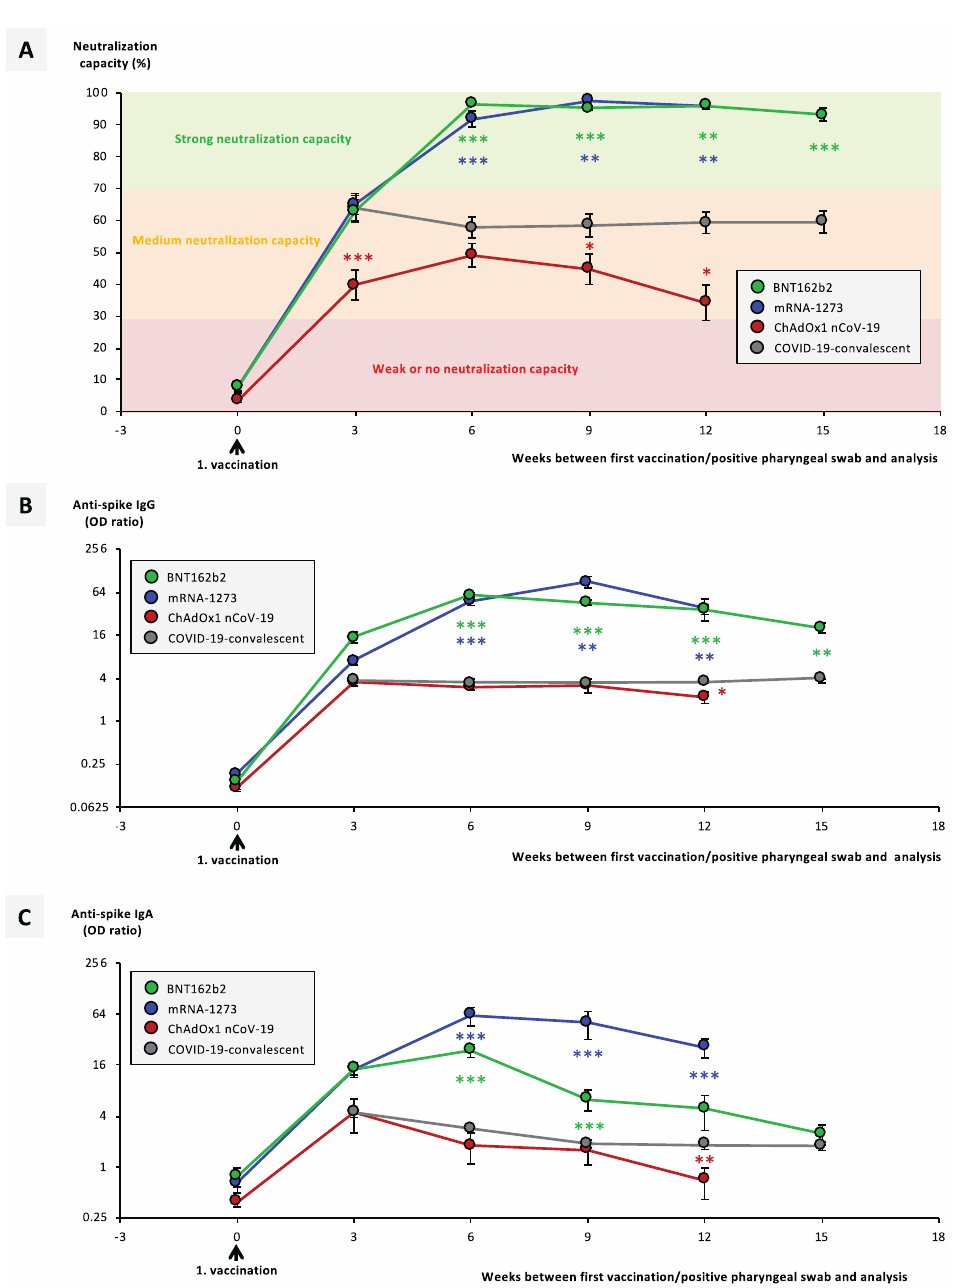
Figure 1. Average antibody and neutralization titers after different anti-SARS-CoV-2 vaccination regimes. Serum samples from 21 BNT162b2- (cohort A), 10 mRNA-1273- (cohort D), and 29 ChAdOx1-nCoV-19 (cohort E)-vaccinated individuals were collected at different timepoints after their first vaccination, as indicated. Second vaccination was given 3 weeks after first vaccination in BNT162b2-, and 4 weeks after first vaccination in mRNA-1273-vaccinated individuals. Serum samples from 162 COVID-19-convalescent individuals, collected at different timepoints after positive pharyngeal swab, served as the control cohort (cohort I). Plotted are average results for ( A ) neutralization of ACE2–RBD interaction, ( B ) anti-spike IgG titers, and ( C ) anti-spike IgA titers. ( A ) Neutralization capacities > 30% were considered positive, neutralization capacities > 70% were considered strong. Error bars indicate SEM; significance levels shown are between vaccinated individuals (colored circles) and convalescent individuals (grey circles) only. Statistical analysis at each timepoint was performed using Dunn’s multiple comparisons test. Significance levels between ChAdOx1-nCoV-19-vaccinated individuals and BNT162b2- or mRNA-1273-vaccinated individuals ranged at the same level as those between convalescent individuals and BNT162b2- or mRNA-1273-vaccinated individuals. Significance levels were * p < 0.05, ** p < 0.005, and *** p < 0.0005. Abbreviations: COVID-19: coronavirus disease 2019; ACE2: angiotensin-converting enzyme 2; RBD: receptor-binding